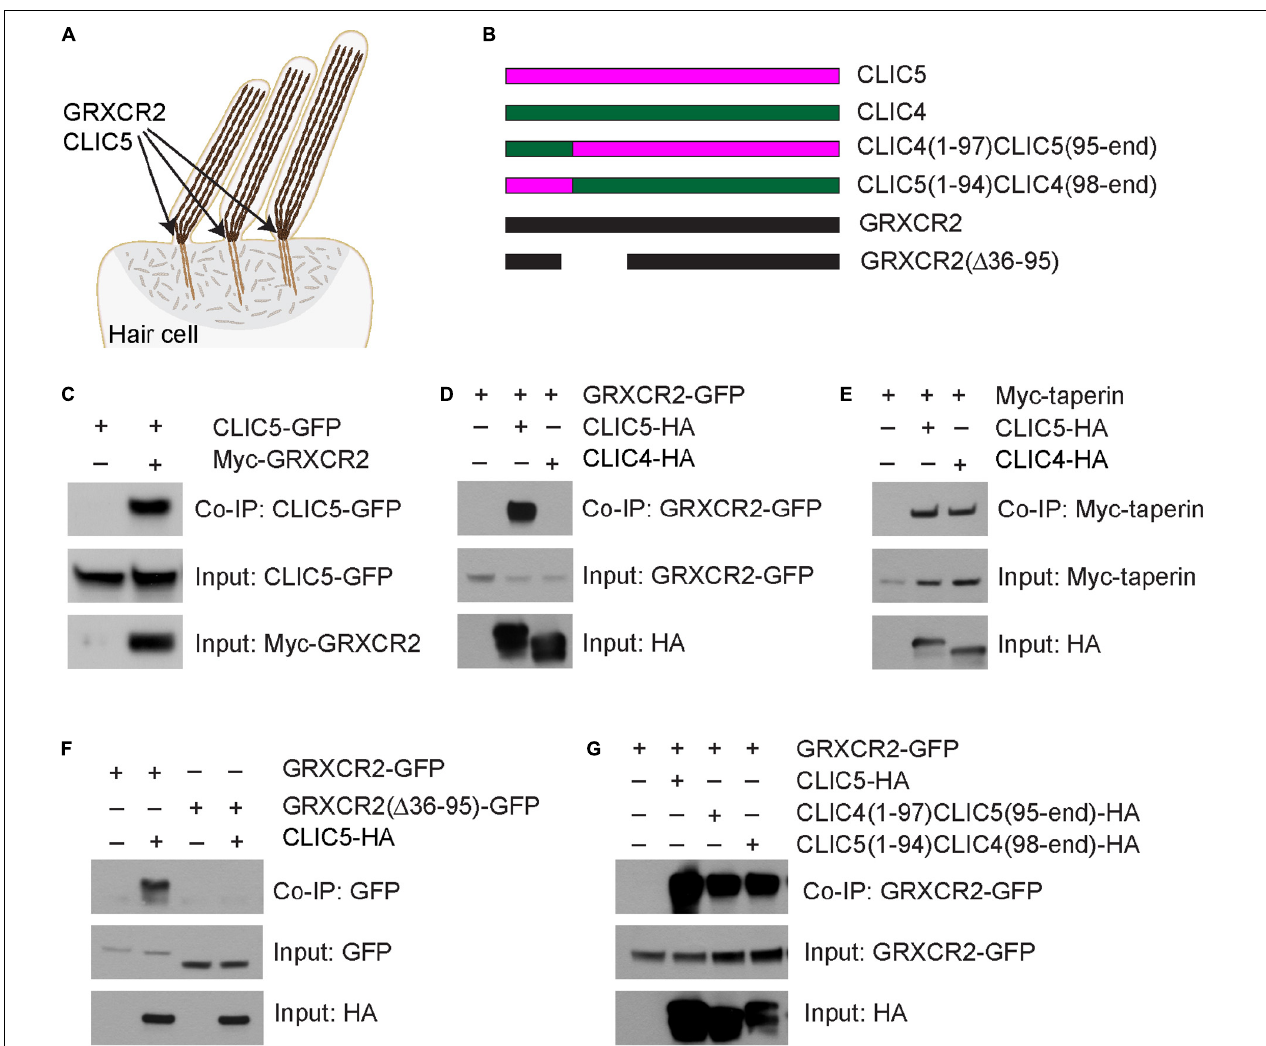
FIGURE 1 | Glutaredoxin domain-containing cysteine-rich protein 2 (GRXCR2) interacts with CLIC5. (A) Diagram of cochlear hair cell showing the staircase-shaped hair bundle. Inside the stereocilia, the tightly cross-linked actin filaments provide the stiffness of stereocilia. GRXCR2 and CLIC5 are concentrated at the base of stereocilia, the site of stereocilia pivoting. (B) Diagram of the constructs used for biochemical experiments. (C–G) HEK293 cells were transfected with the constructs indicated on the top of each panel. Immunoprecipitations were carried out with Myc-antibody (C) or HA-antibody (D–G) followed by western blotting to detect co-expressed proteins. The upper rows show Co-IP results and lower rows show input